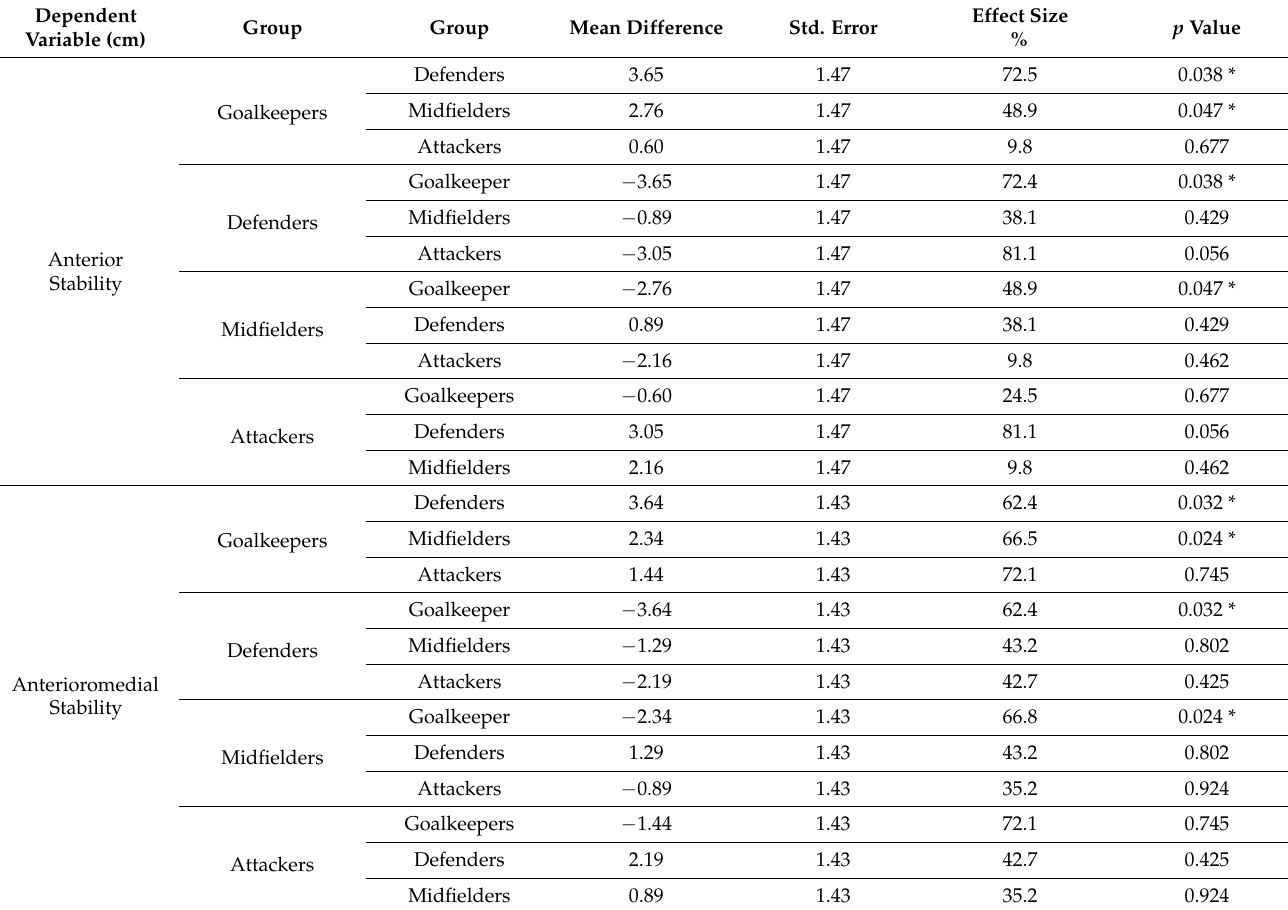
Table 5. Post-Hoc (Tukey) analysis of dynamic stability values of soccer players for their playing